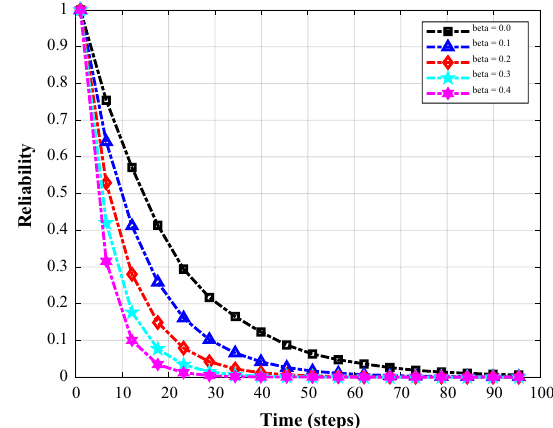
Fig. 11 Reliability performance at medium system diagnostic coverage level and 95% repair